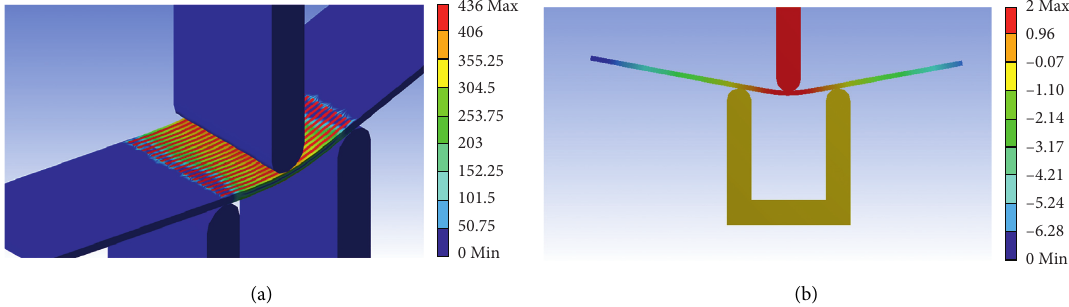
Figure 11: Computer simulation of bending test in Ansys workbench: (a) stress distribution in a bent element; (b) strains degree of the bent element under load.